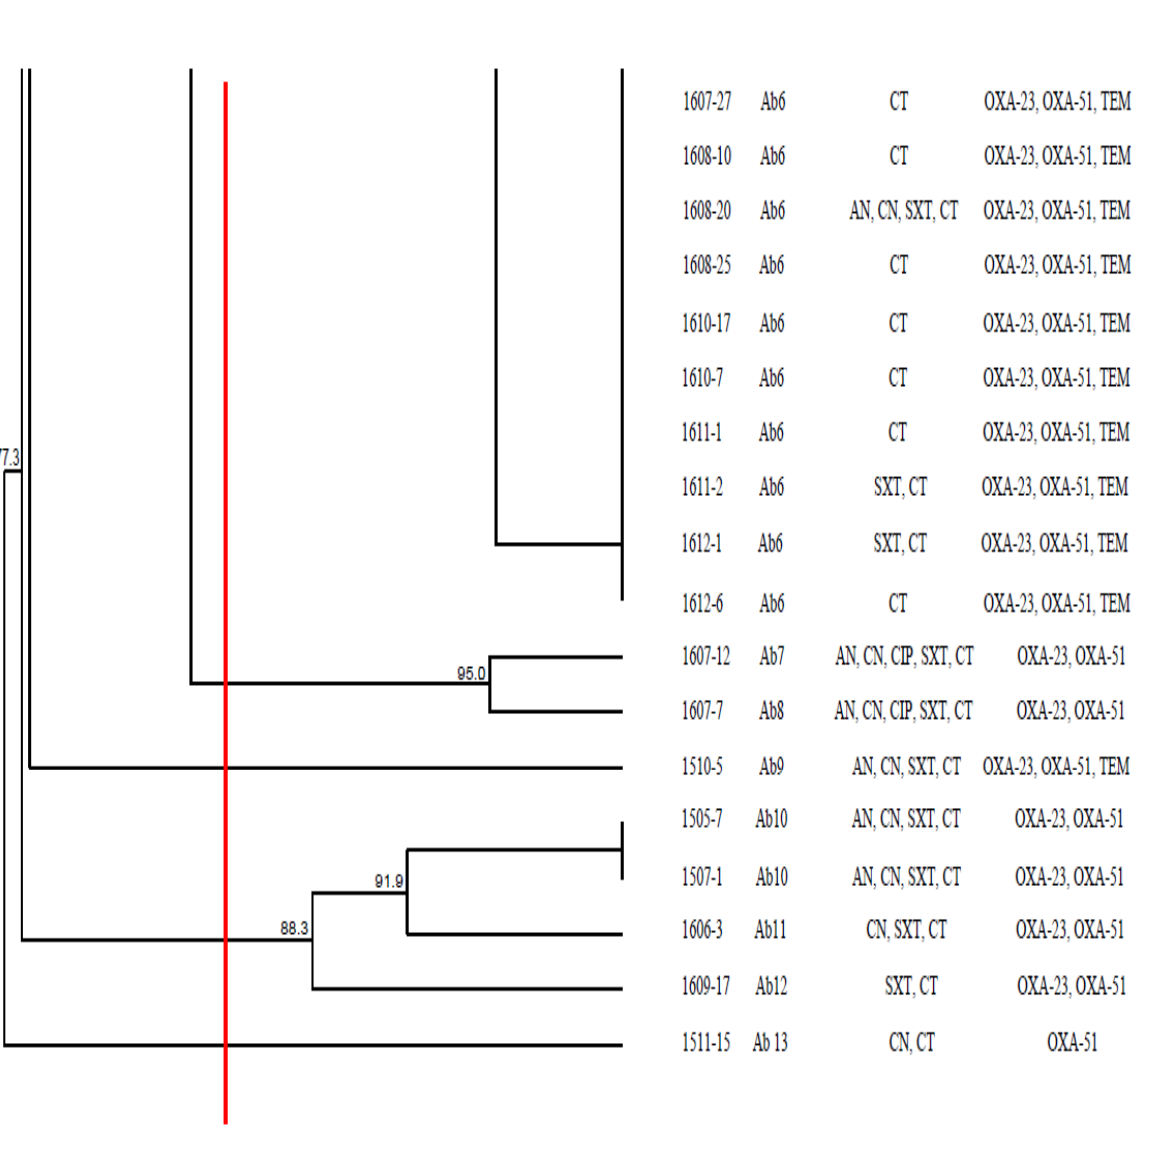
Figure 3. Dendrogram generated with dice coefficient and the UPGMA clustering method based on the PFGE banding pattern of 100 CRAB isolates, showing the genetic similarity among the isolates, together with their respective pulsotype, class of antibiotics in which the isolate remains susceptible to, the carriage of carbapenem and ESBL-resistant determinants. The red line represents the similarity threshold of 85%. Abx: Antibiotics; AN: Amikacin; CIP: Ciprofloxacin; CN: Gentamicin; SXT: Trimethoprim–sulfamethoxazole; CT: Colistin. *: Outgroup.